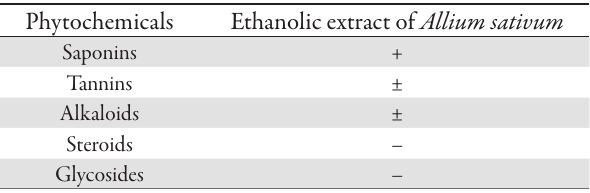
Tab. 1. Phytochemical screening of ethanolic extracts of Allium